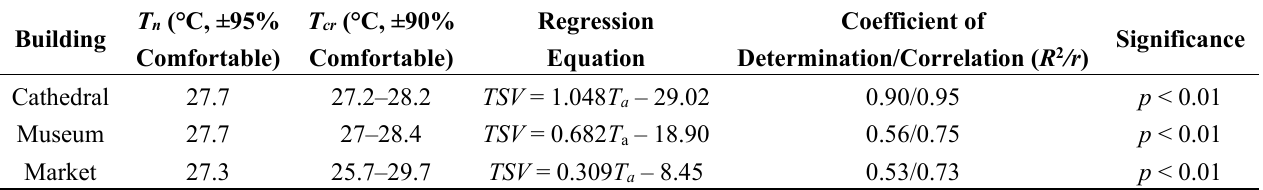
Table 4. Neutral temperature ( T n ) and comfort range ( T cr ) in terms of air temperature.